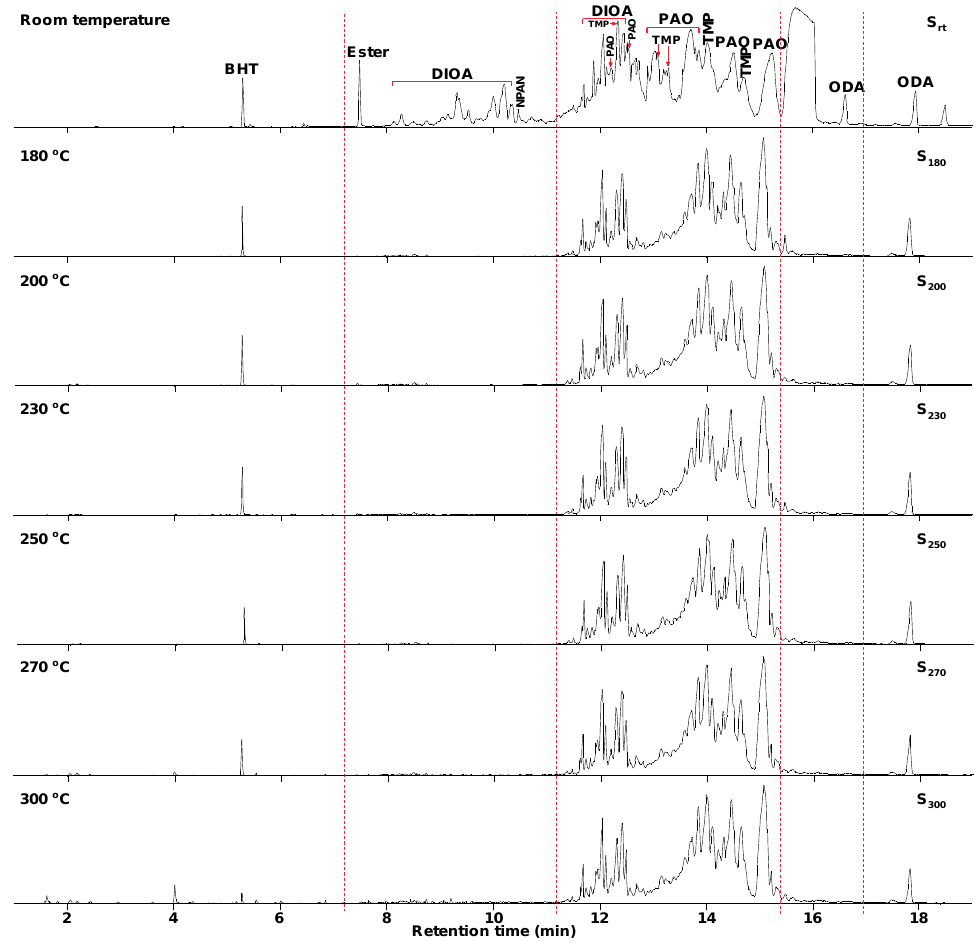
Figure 4. Total ion chromatograms (TIC) of the oil samples as a function of temperature.